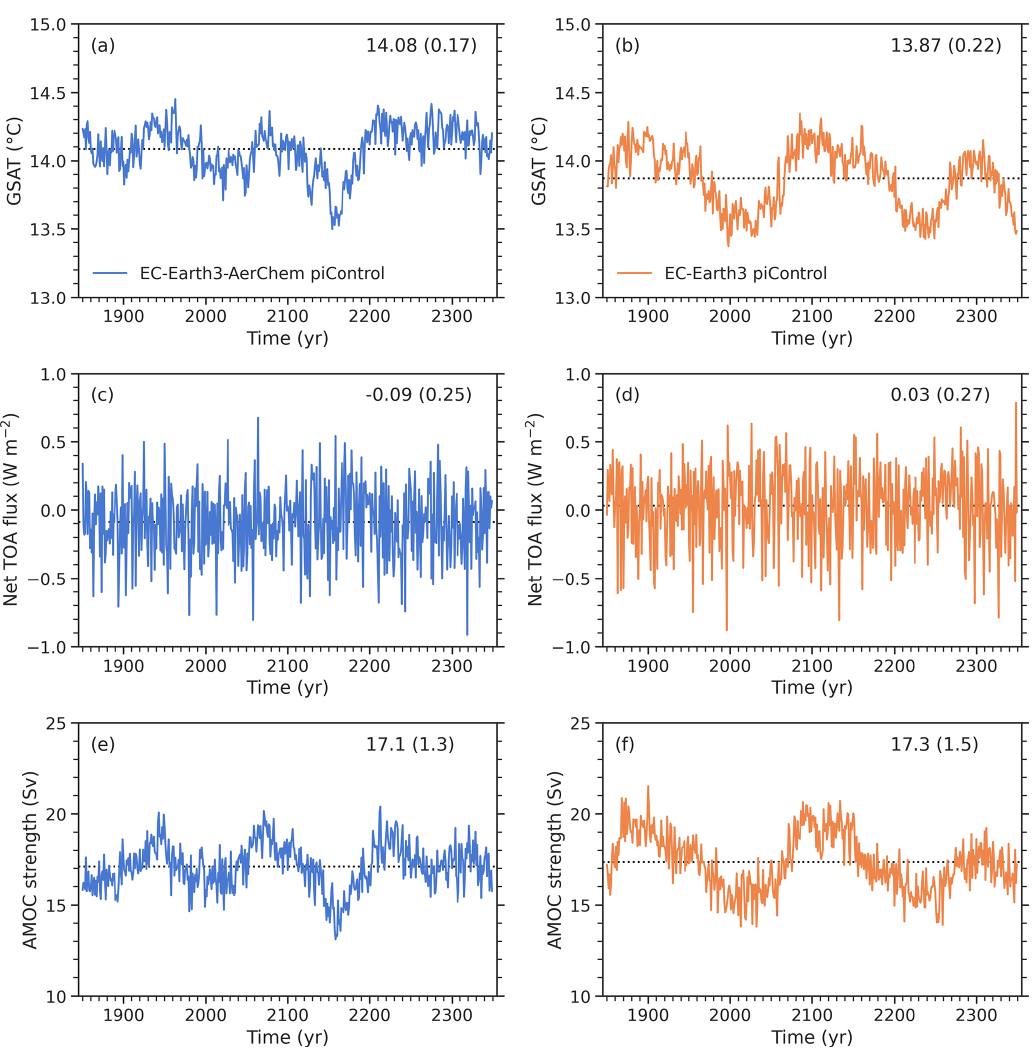
Figure 2. Time series of the global surface air temperature (GSAT), the global net radiative flux at the top of the atmosphere (TOA), and the strength of the Atlantic meridional overturning circulation (AMOC) at 26 ◦ N in the preindustrial control simulation (piControl) of EC- Earth3-AerChem and EC-Earth3. All data points are annual means; the numbers given in the top right of each panel are the mean and interannual standard